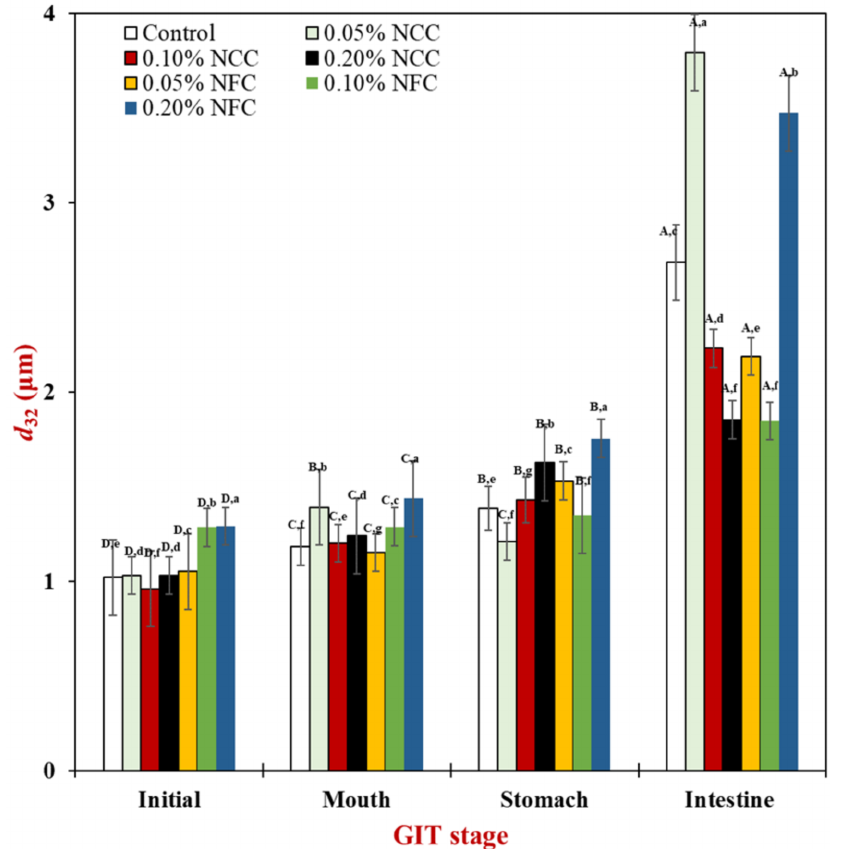
Figure 3. Influence of nanocellulose and gastrointestinal tract (GIT) stage on mean droplet diameter of 10% ( w / w ) O/W emulsions containing β -carotene. Samples designated with different capital letters (A − D) were significantly different (Duncan, p < 0.05) when compared between different GIT stages (same stabilizer). Samples designated with different lowercase letters (a − g) were significantly different (Duncan, p < 0.05) when compared between different stabilizer (same GIT